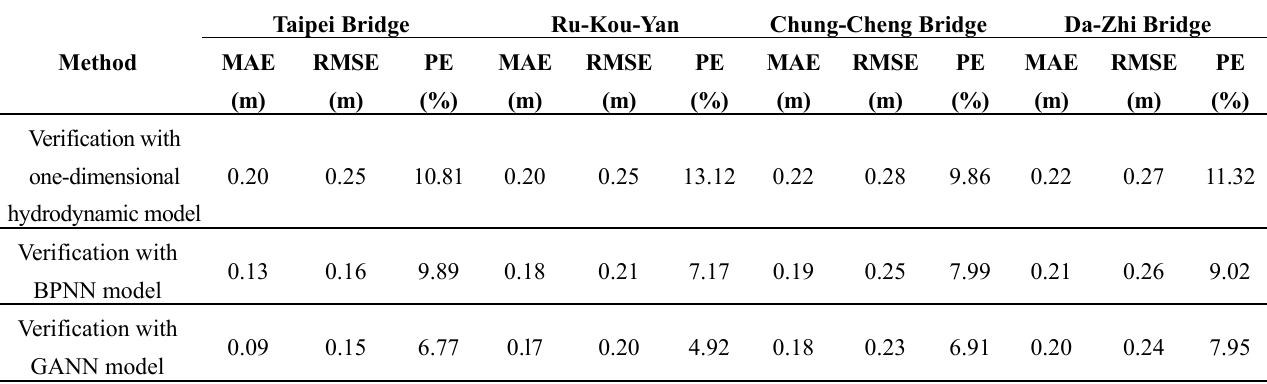
Table 5. The performance of the one-dimensional flood routing hydrodynamic model, the BPNN model and the GANN model with respect to predicting the water stage during the verification phase at four